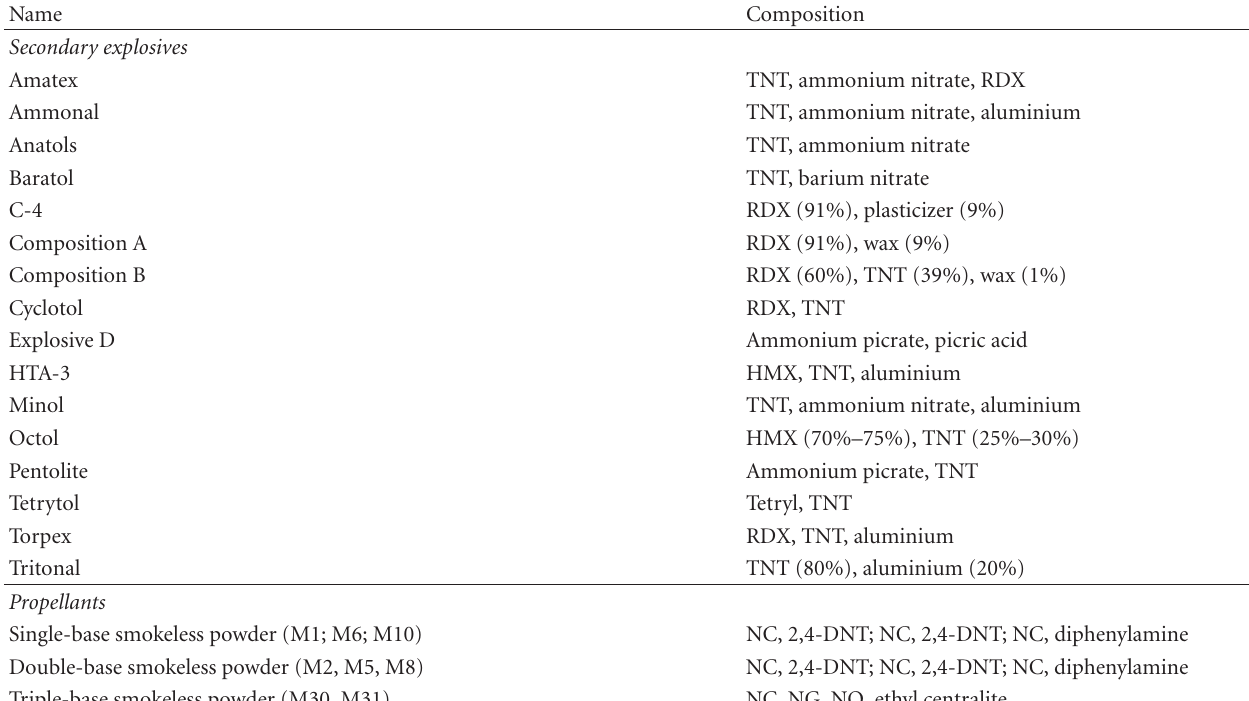
Table 1: Composition of common military energetic materials (adapted from [36, 38, 39]).